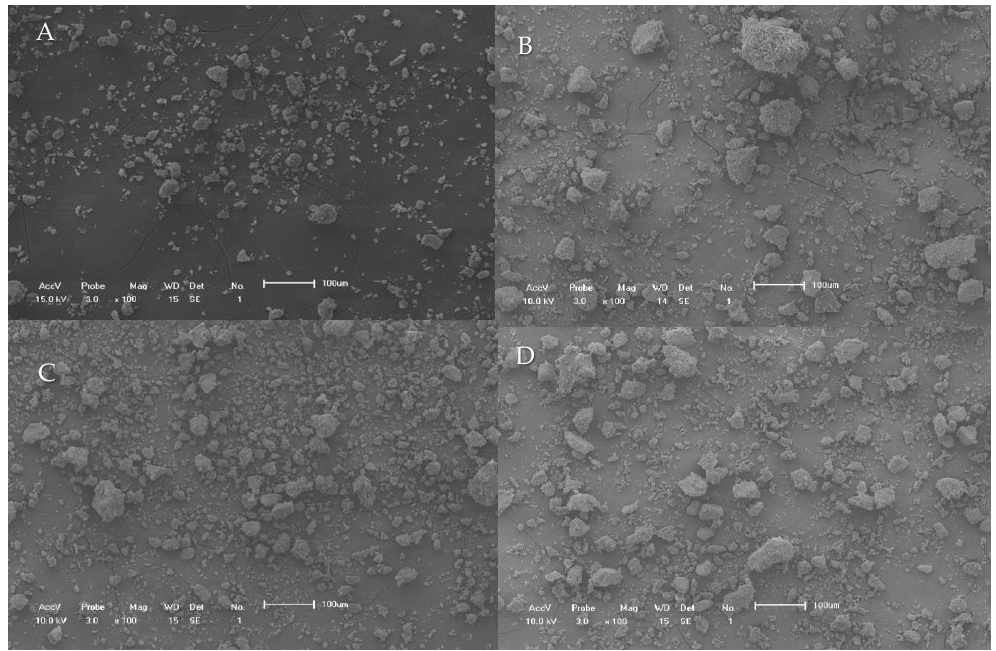
Figure 6. SEM 100× magnitude compilation. ( A ) 5%Ru/HPS; ( B ) 3%Ru@0.1%Co/HPS; ( C ) Figure 6. SEM 100 × magnitude compilation. ( A ) 5%Ru/HPS; ( B ) 3%Ru@0.1%Co/HPS; 3%Ru@0.1%Cu/HPS e; ( D ) 3%Ru@0.1%Ni/HPS. ( C ) 3%Ru@0.1%Cu/HPS e; ( D )